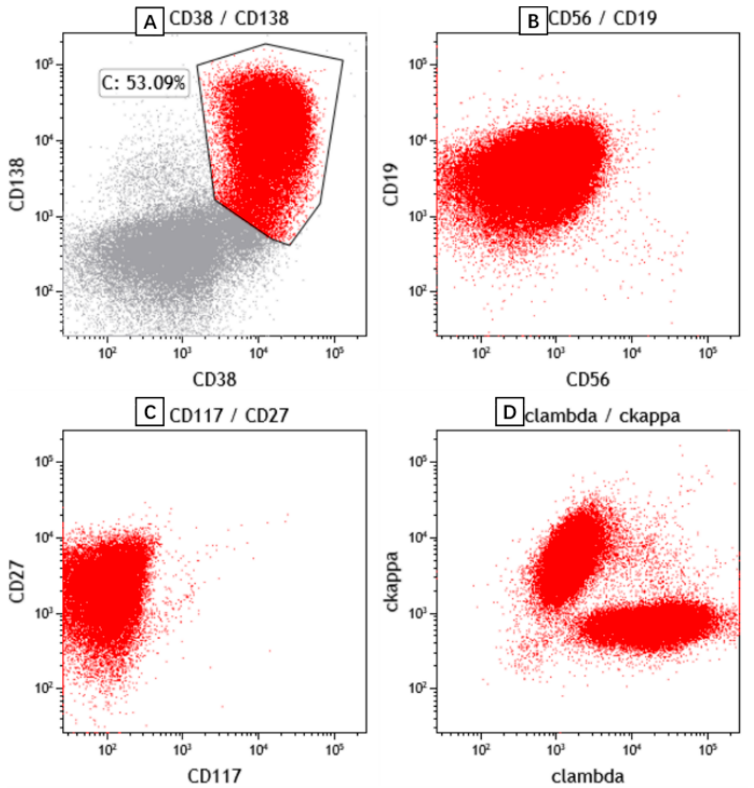
Figure 3. Representative scatter plots of pleural effusion flow cytometric immunophenotyping. The plasma cells express CD38, CD138 ( A ), CD19 ( B ), CD27 ( C ) and polyclonal immunoglobulin light chain kappa and lambda ( D ).